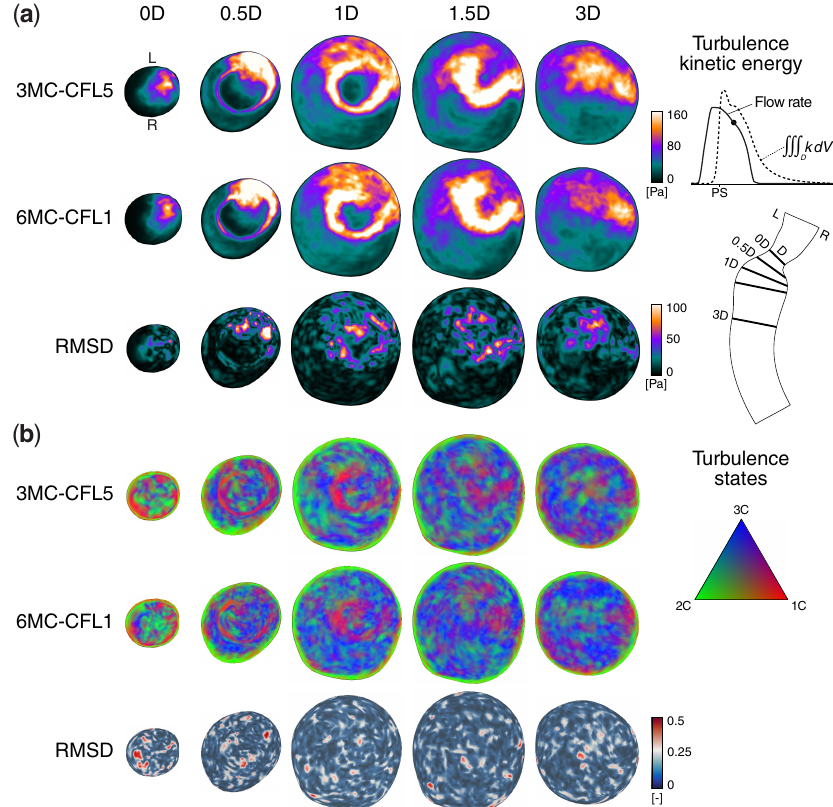
Figure 2. Spatiotemporal resolution effects on the phase-instant Reynolds stress characteristics in the post-stenotic region. The well-resolved case (6MC-CFL1) was compared against a lower mesh and time-step size resolution (3MC-CFL5), by considering the contours of ( a ) turbulence kinetic energy ( k ) and ( b ) turbulence stress-states, including the point-wise root-mean-square deviations (RMSD, i.e., k rms and C rms ). The cross-sectional planes were positioned normal to a centerline at the smallest stenotic diameter (D) and at four downstream locations (0.5D, 1D, 1.5D and 3D). The time snapshot (phase-instant) was considered at the early flow deceleration (EFD) phase (inset, solid line and marker), where the overall turbulence kinetic energy (TKE) in the computational domain was elevated/developed (inset, dashed line). The symbols L and R denote the left and right side of the aorta, respectively. All results were phase-averaged over 50 cardiac cycles ( N = 50). The mean RMSD errors are given in Figure 3 (Instant, black